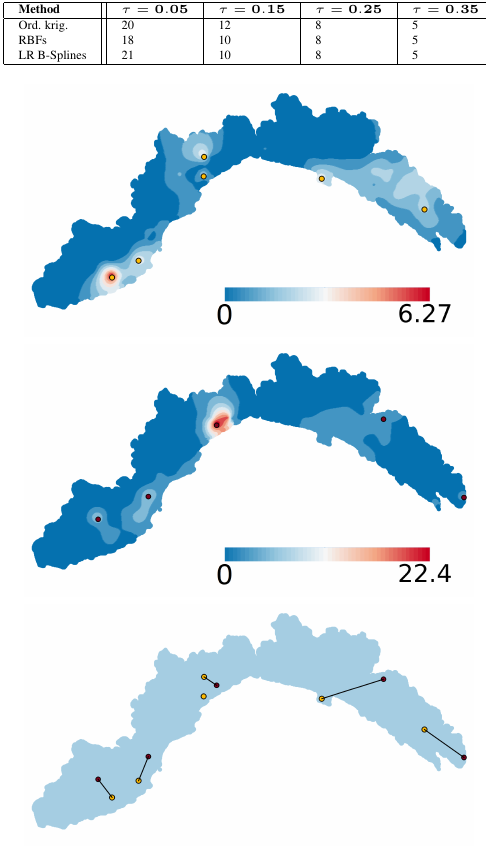
Figure 6: Two fields F, G : M → R , color-coded from blue (low) to red (high) values, and the associated local maxima. On the right, bottleneck matching between local